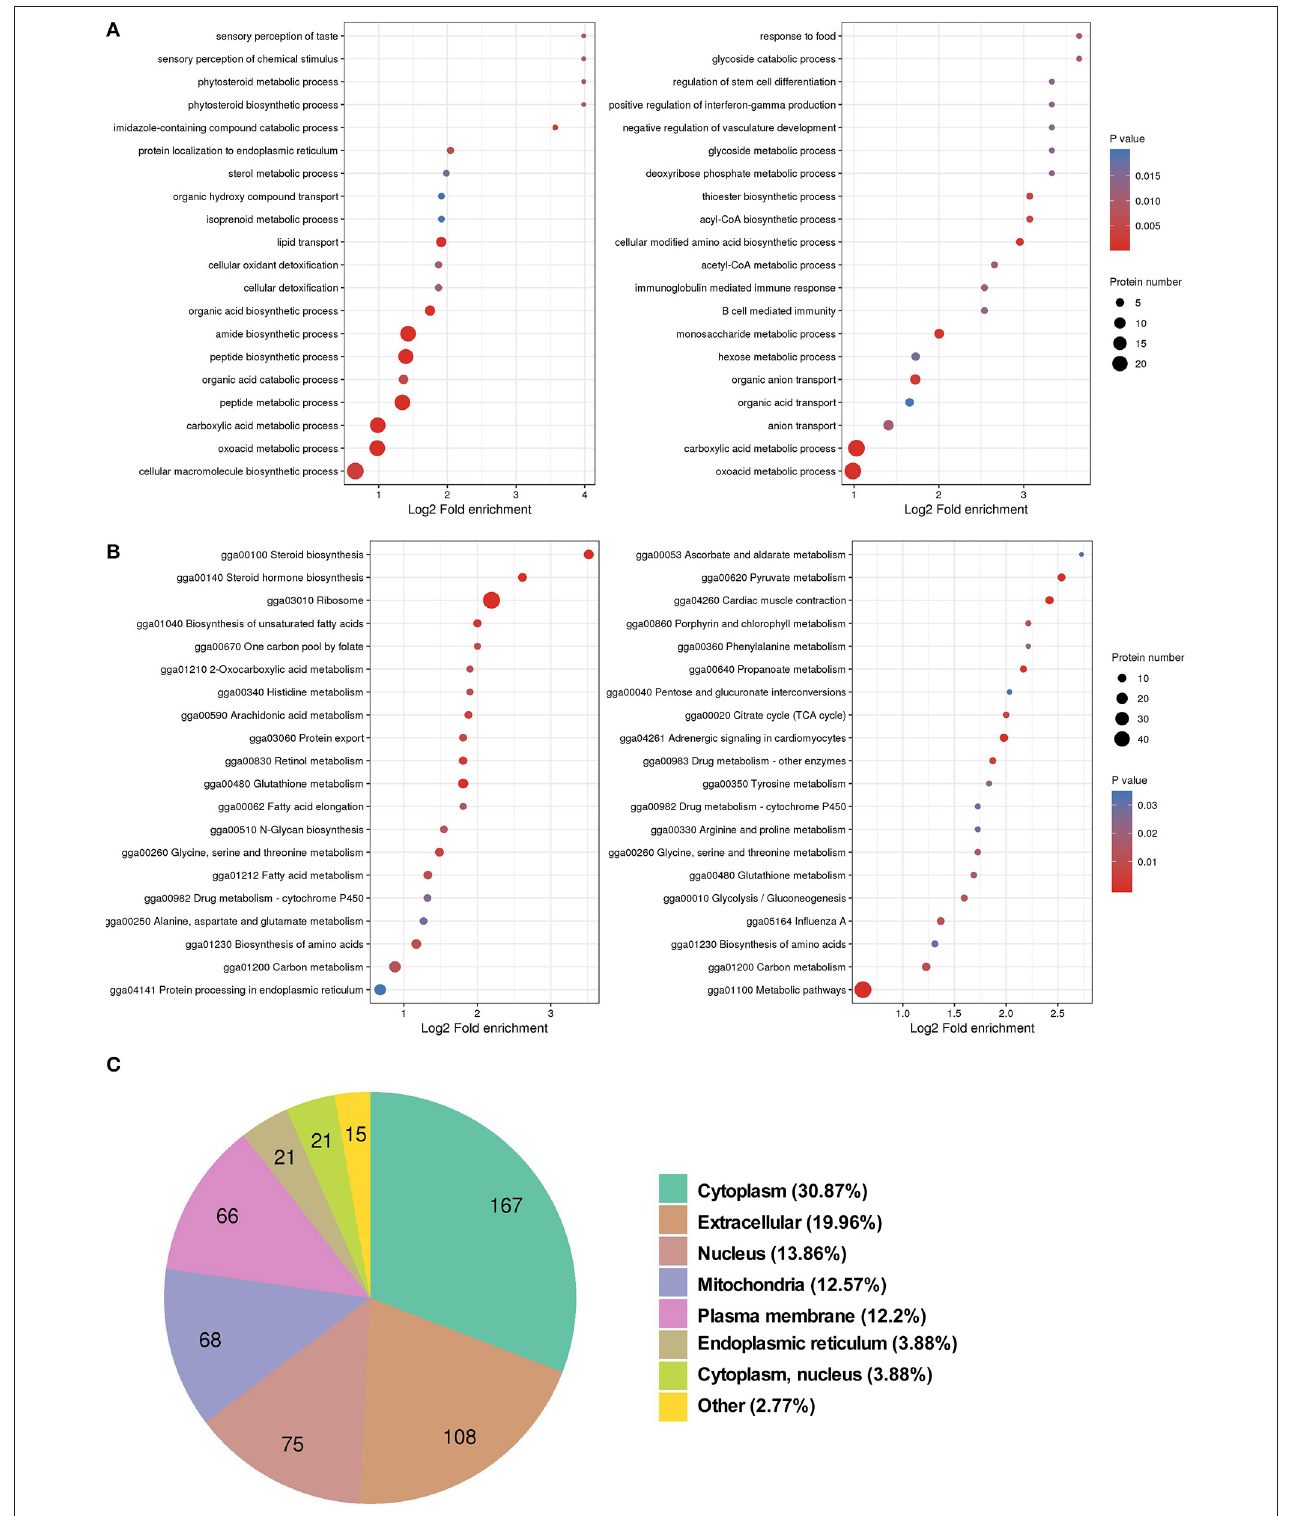
FIGURE 2 | GO and KEGG enrichment analyses, and subcellular localization of SDEPs. (A) GO enrichment analysis of SDEPs. The significantly enriched ( p ≤ 0.05) biological process, cellular component, and molecular function categories are shown at the left box (for upregulated proteins) and right box (for downregulated proteins), respectively. (B) KEGG enrichment analysis of SDEPs. The significantly enriched ( p ≤ 0.05) pathways are shown at left box (for upregulated proteins) and right box (for downregulated proteins). (C) Subcellular localization of